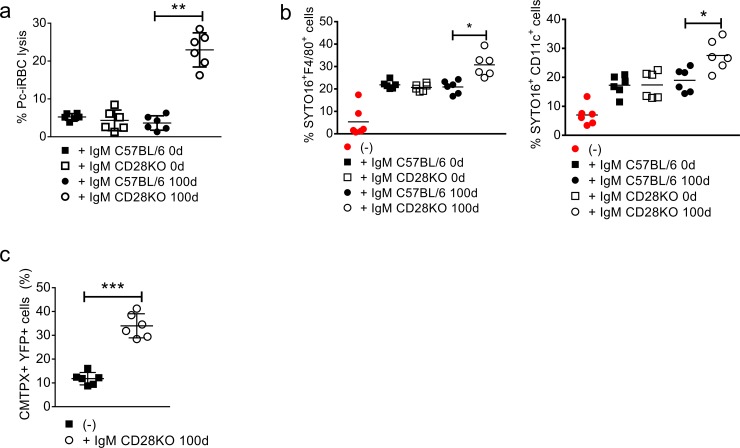
Lysis and phagocytosis of Pc-iRBCs that was mediated by IgM produced from chronically infected C57BL/6 and CD28KO mice.(a-c) IgM was purified from serum samples of mice on day 100 p.i. and age-matched controls (0d). (a) Lysis of mature Pc-iRBCs that was mediated by purified IgM in the presence of complement components (RAGKO mouse serum). The iRBC lysis percentages were determined in relation to negative (PBS) and positive (H2O) controls. (b)
In vitro uptake by splenic F4/80+ macrophages and dendritic cells of mature iRBCs, which were or were not previously incubated with purified IgM from chronically infected CD28KO mice. SYTO 16-labeled Pc-iRBCs from RAGKO mice were incubated with purified IgM for 30 min and then cultured with phagocyte-enriched splenocytes for 20 min. The SYTO 16+F4/80+ cell and SYTO 16+CD11c+ cell percentage data are shown, which was obtained by flow cytometry. (c)
In vivo uptake by splenic red pulp dendritic cells of mature iRBCs, which were or were not previously incubated with purified IgM. The CMTPX-labelled iRBCs from the RAGKO mice was incubated with purified IgM and inoculated i.v. into CD11c-YFP mice. The scale bars represent 50 μm. The CMTPX+YFP+ cell percentage data in the YFP+ cell population is shown. In a-c, significant differences (*p<0.05, **p<0.01, ***p<0.001) between the experimental groups are shown. Data from three independent experiments (n = 6, mean ± SEM) is shown.